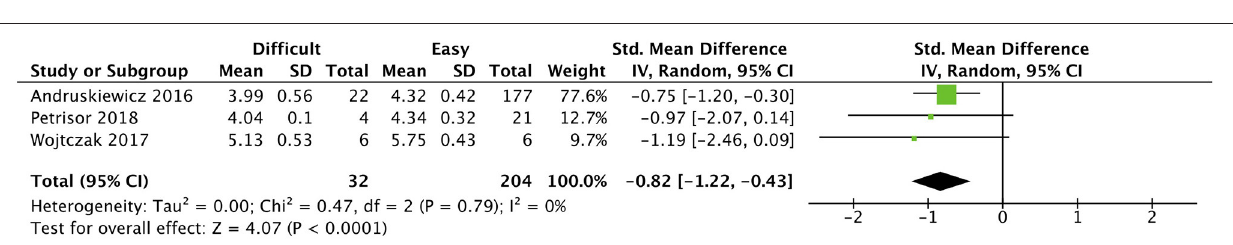
FIGURE 8 | HMD in neutral position forest plot comparing difficult and easy laryngoscopy groups.